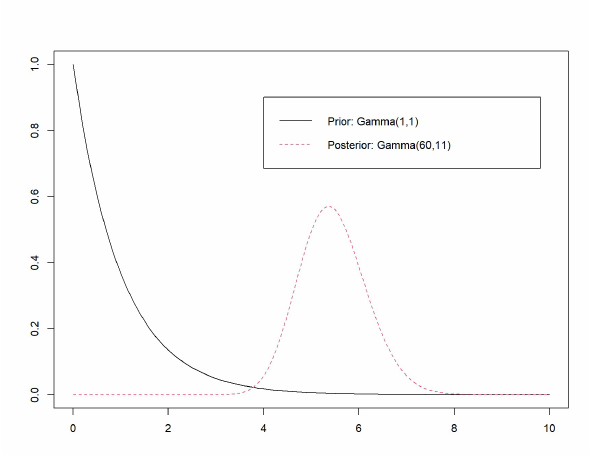
Figure2. prior and (60,11) posterior of theta. Here, black solid line denotes the prior distribution, red dotted line denotes the posterior distribution.